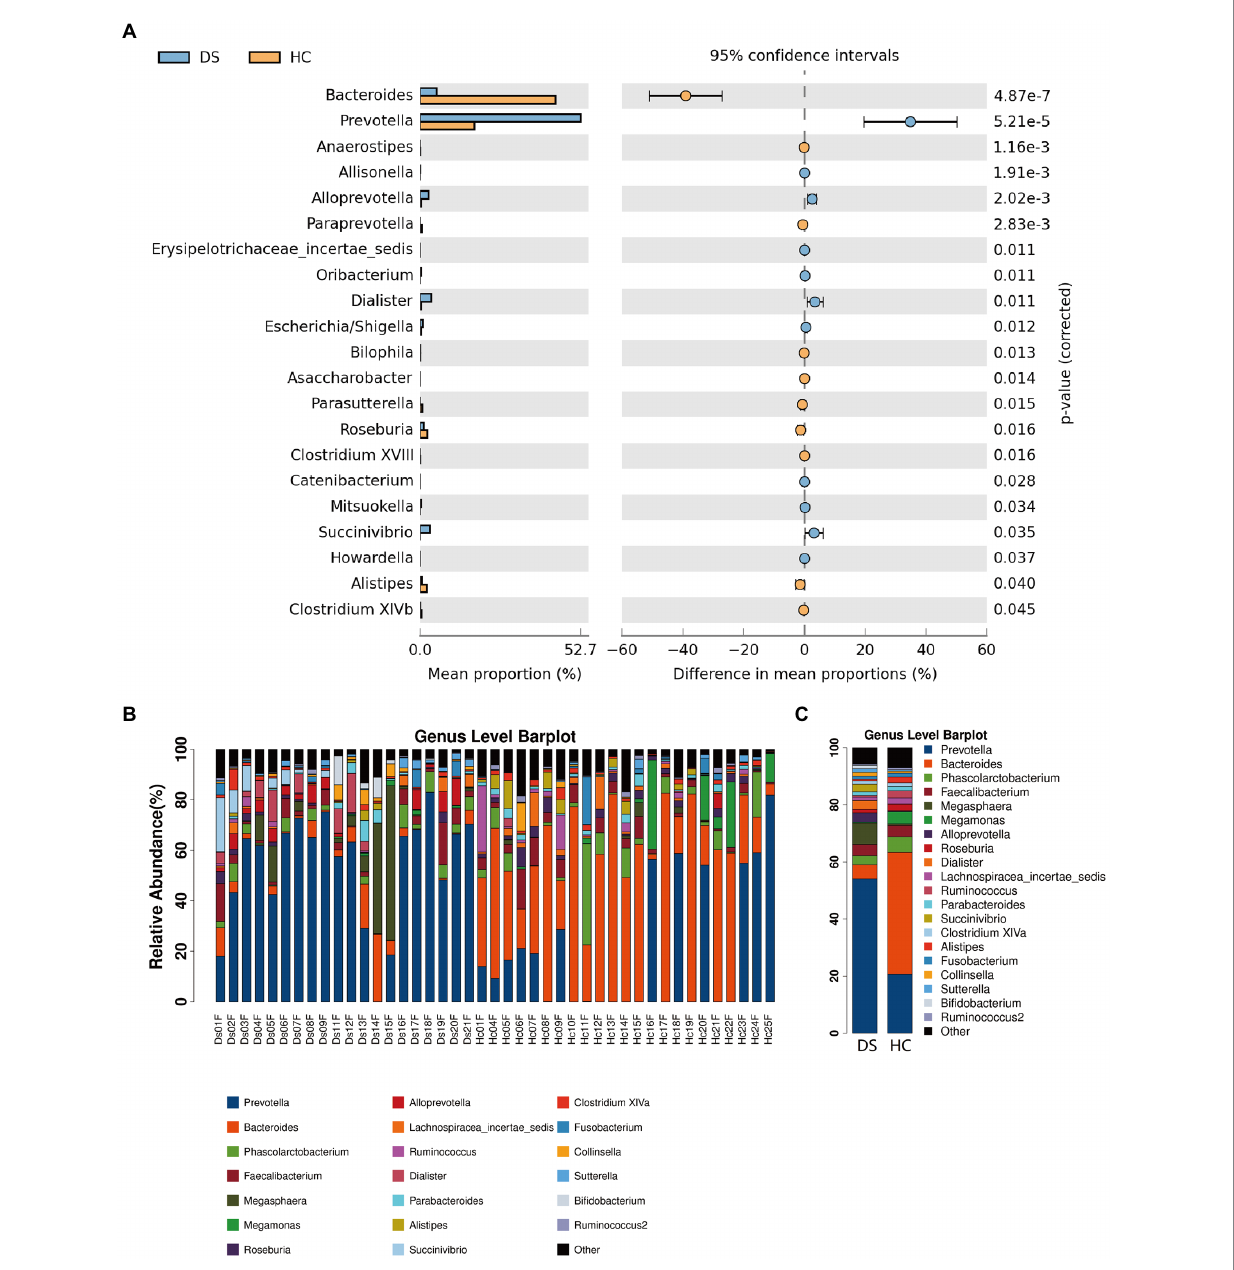
FIGURE 4 Differences in microbial composition between individuals with DS (DS) and non-DS volunteers (HC) at the genus level. (A) Mean proportion (left) and difference in mean proportion (right) of each genus present in the microbiome of DS and non-DS groups. (B) Fecal microbial richness of each DS and non-DS volunteer at the genus level. (C) Mean composition and richness of fecal microbiota in individuals with DS and non-DS